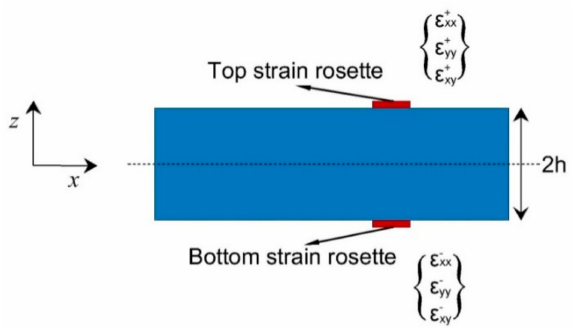
Figure 2. Discrete strains measured on structural